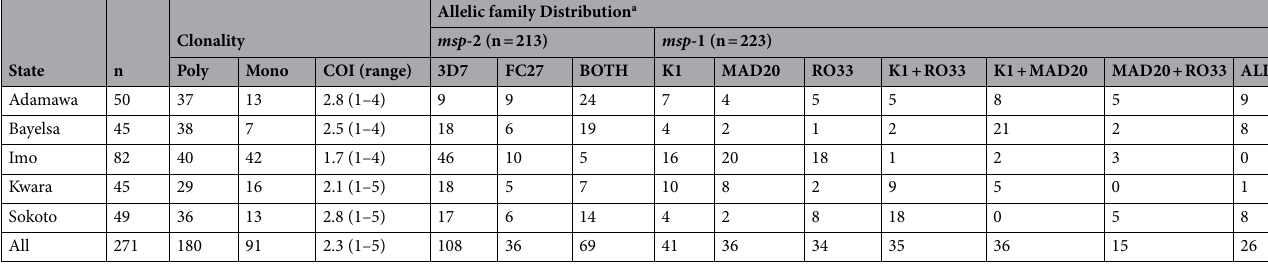
Table 2. Parasite clonality, Complexity of Infection and Allelic family distribution. a All 271 samples were